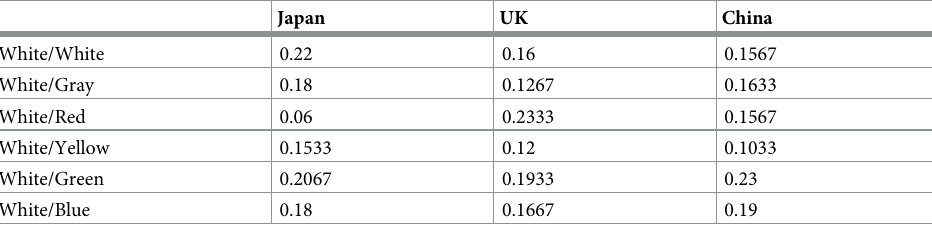
Table 8. FAHP weight table of different